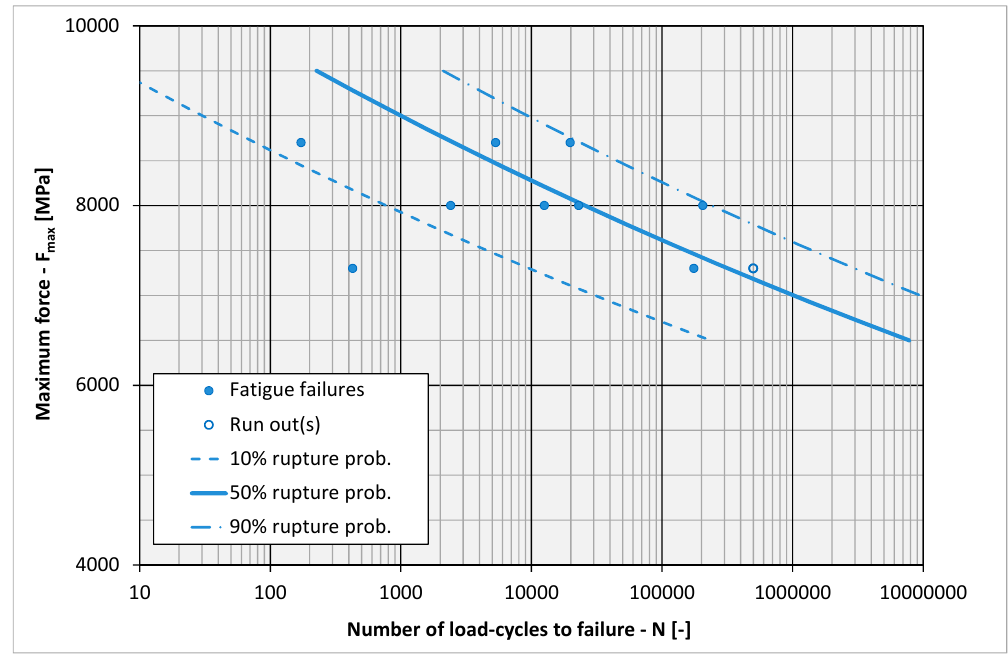
Figure 18. Experimental data and the modelled Woehler curves for different probabilities of failure.